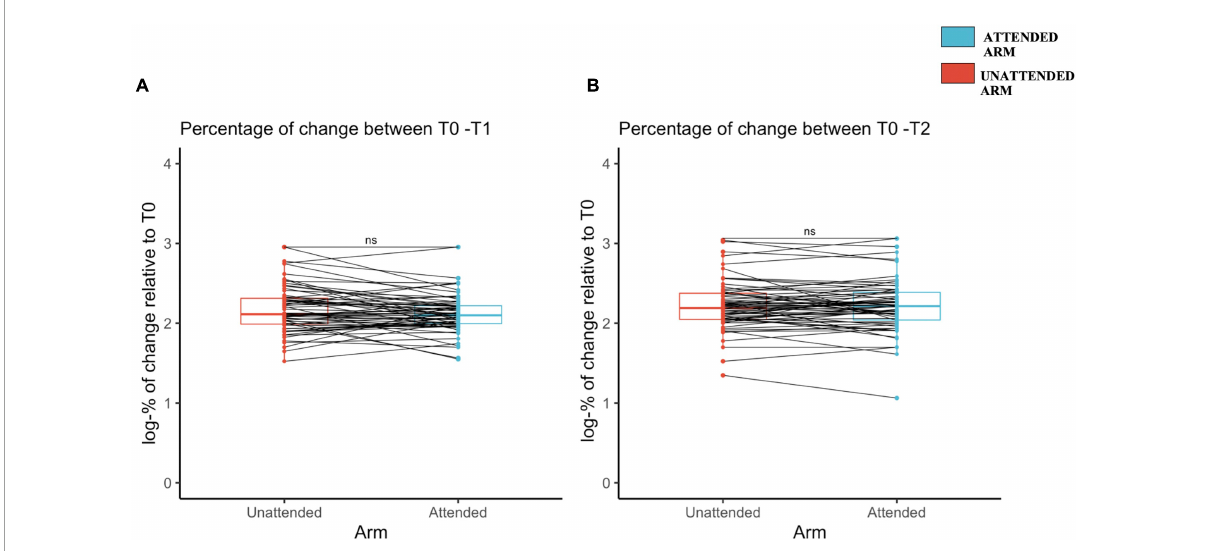
FIGURE3 Increased mechanical pinprick sensitivity induced by high-frequency stimulation (HFS) between the unattended and attended arm (A) immediately after the induction of high-frequency stimulation, and (B) 20 min later, assessed using a probe with an exerting force of 128 mN. The red (unattended arm) and the blue (attended arm) bold lines in the boxplots represent the median of the perceived intensity in terms of percentage of change logarithmically transformed. A one-sided paired sample t -test was used to compare the log-transformed percentage of change in mechanical sensitivity from T1 to T0 (A) and from T2 to T0 (B) . Each dot represents a single participant perceived intensity in terms of percentage of change logarithmically transformed for each arm and at the measured time point, T1 (A) and T2 (B) . The continuous line indicated with “ns” means that there was no significant difference between the two conditions, attended and unattended.